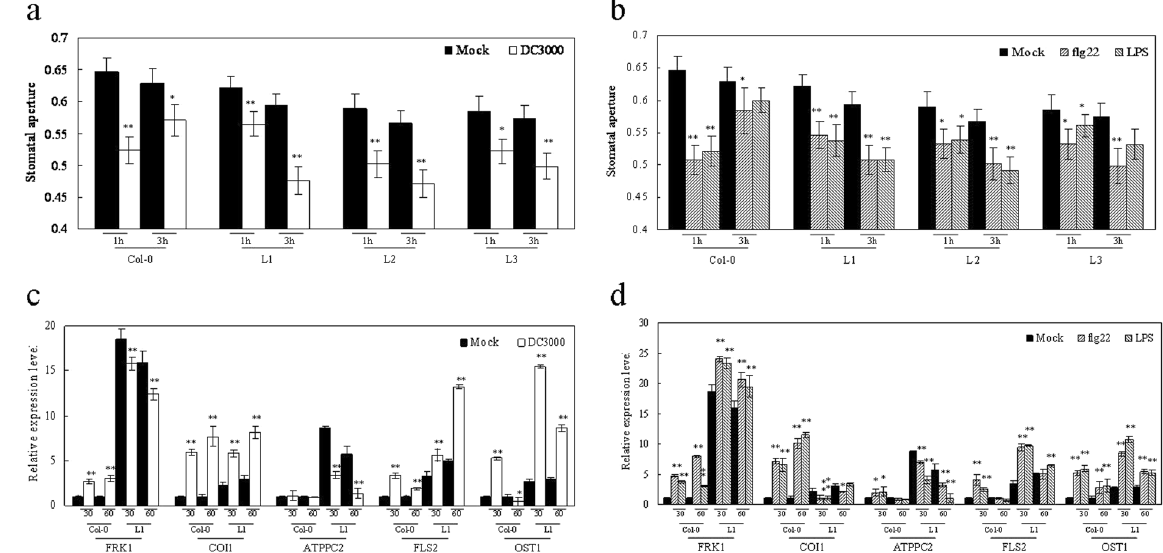
Figure 7. Altered stomatal immunity response in VqTLP29 over-expressing Arabidopsis thaliana lines. ( a , b ) Stomatal apertures (width/length; µ m) in epidermal peels of the leaves in the 4-week old VqTLP29 transgenic line L1, L2, L3 and Col-0 after 1 h and 3 h of incubation with ( a ) Mock sample (MgCl 2 ) and DC3000; ( b ) Mock (MgCl 2 ), flg22 and LPS. Data represent mean values ± SD with 60 stomata per sample. Stomatal apertures of the transgenic lines and Col-0 were combined and analyzed with the microscope and software Image-J in three independent experiments. Data represent mean values ± SD with 60 stomatal per sample. Asterisks indicate statistical significance ( * 0.01 < P < 0.05, ** P < 0.01, one-way ANOVA). ( c , d ) Expression levels of stomatal immunity response related genes in the VqTLP29 transgenic line L1 and Col-0 after 30 min and 60 min of incubation. Asterisks indicate statistical significance ( * 0.01 < P < 0.05, ** P < 0.01, one-way ANOVA). The experiments were repeated three times with consistent